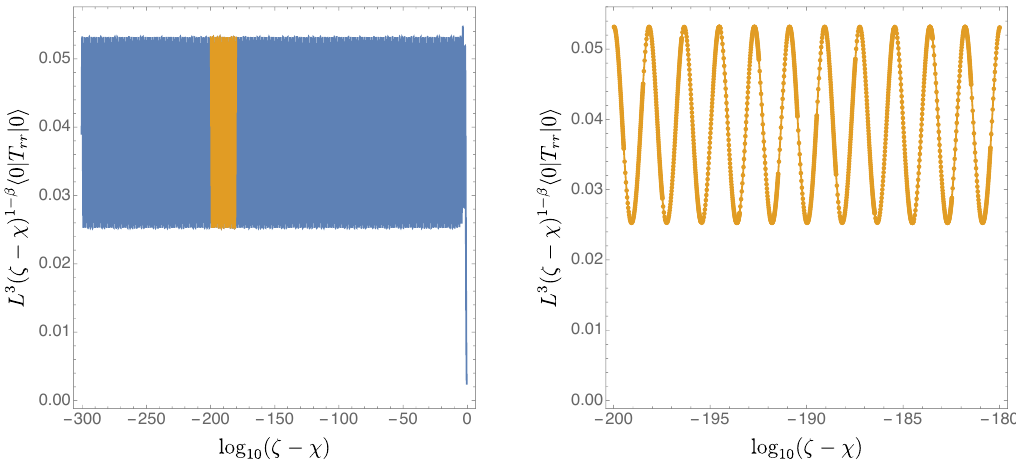
( (cid:16) (cid:0) (cid:31) ) < (cid:0) 180 showing the discrete 10